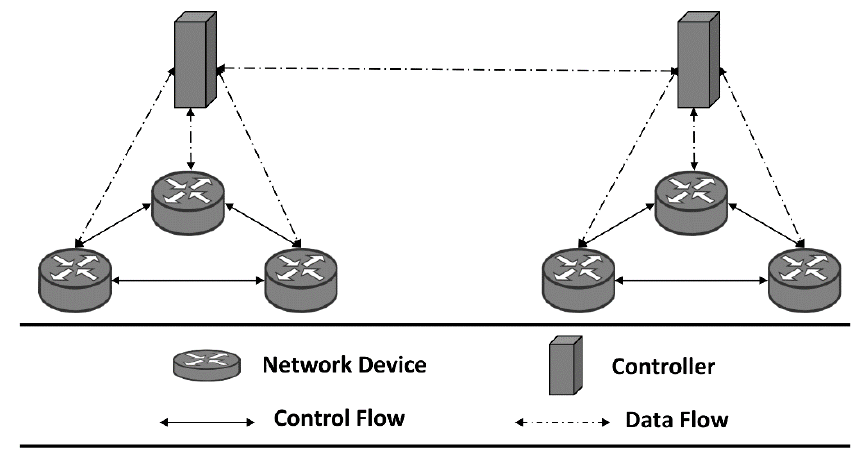
Figure 4. Distributed Flat Controllers Design .